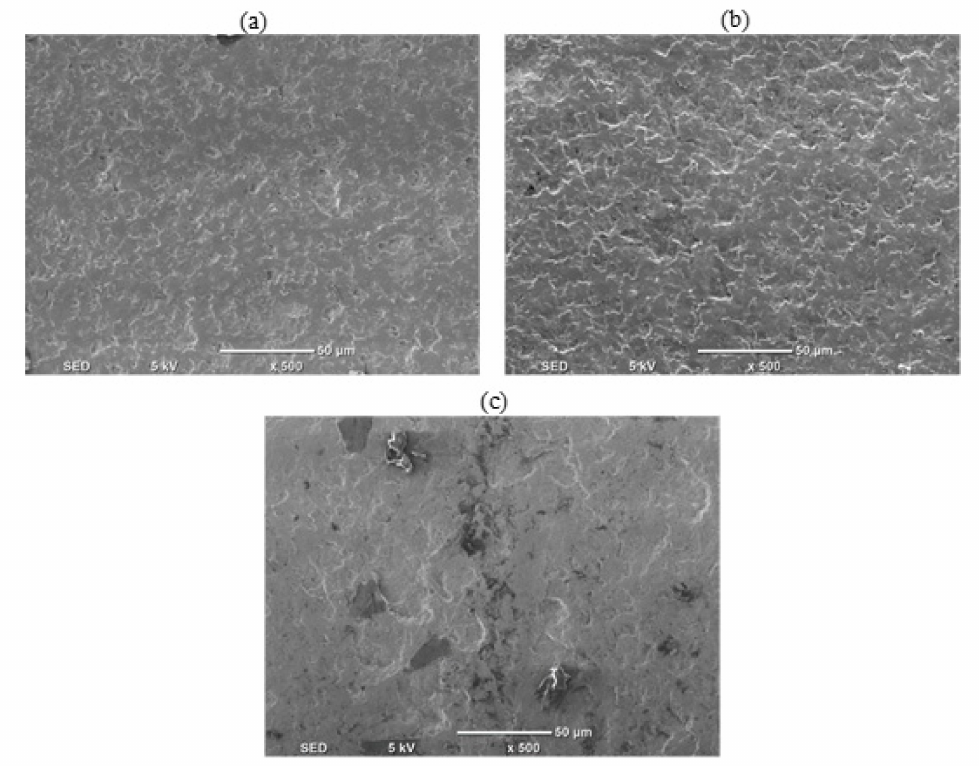
Figure 9. Surface morphology of the machined pockets ( a ) Exp. #3, ( b ) Exp. #10, and ( c ) Exp. #6.